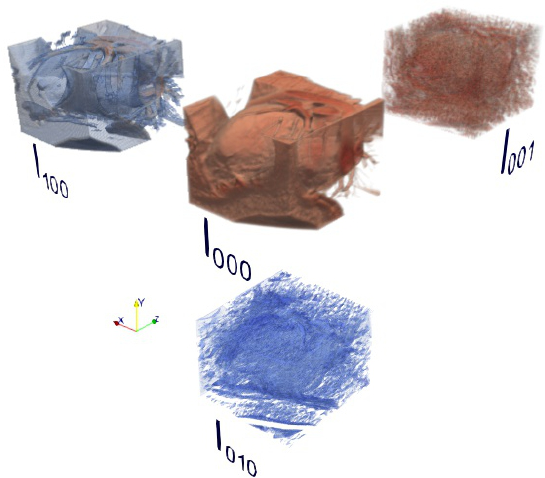
Figure 5. Ensemble of some Steered Hermite coefficients of a cardiac CT